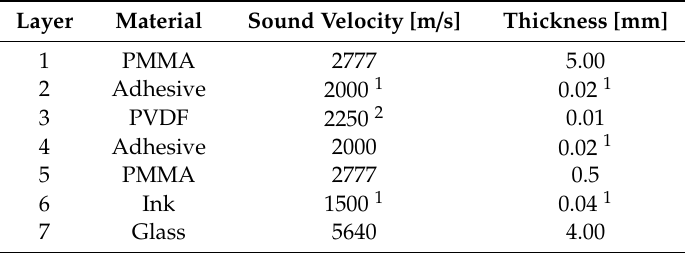
Table 1. Material layers as used in the measurements and simulation. The data sheet of the Norland Optical Adhesive does not include the sound velocity. The adhesive layer thickness is estimated from empirical values obtained in applications in other fields.